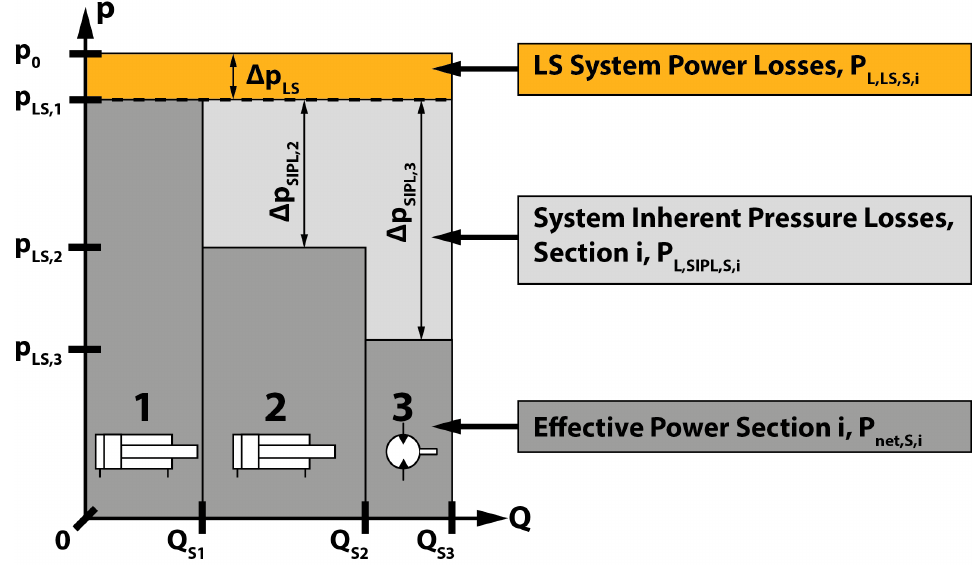
Figure 1. p/Q diagram of a LS system with three different actuators [9]. Reproduced with permission from the publisher.